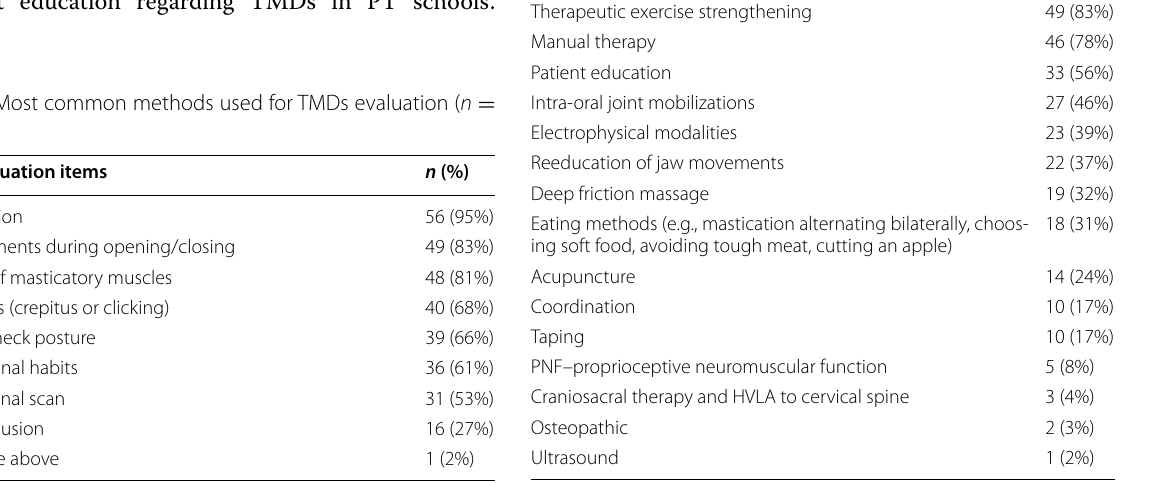
n number, % percentage, HVLA high velocity-low